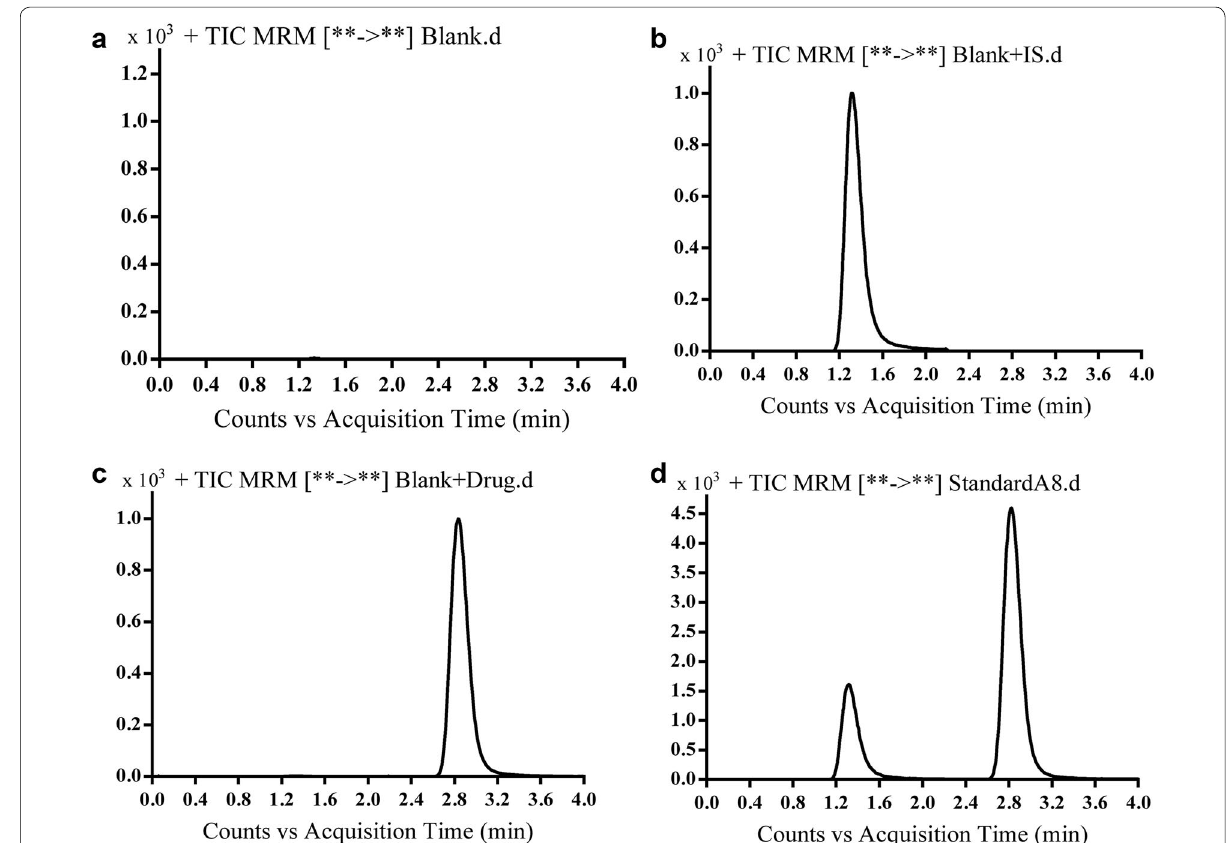
Fig. 2 Total ion chromatogram of MRM of a blank, b blank spiked with 200 ng/ml of IS, c blank spiked with 100 ng/ml of CVA and d blank spiked with 200 ng/ml IS and 100 ng/ml drug